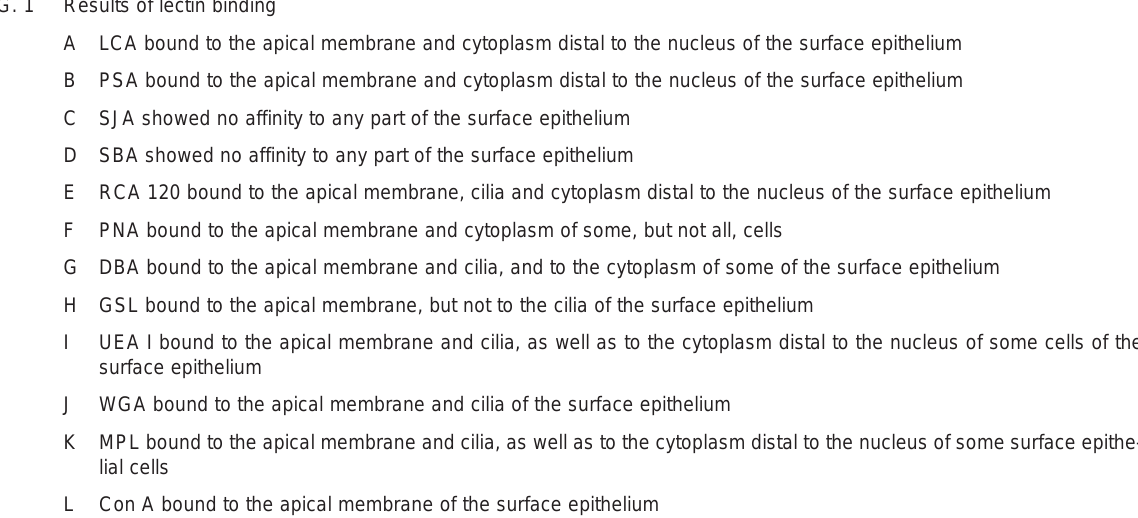
Results of lectin